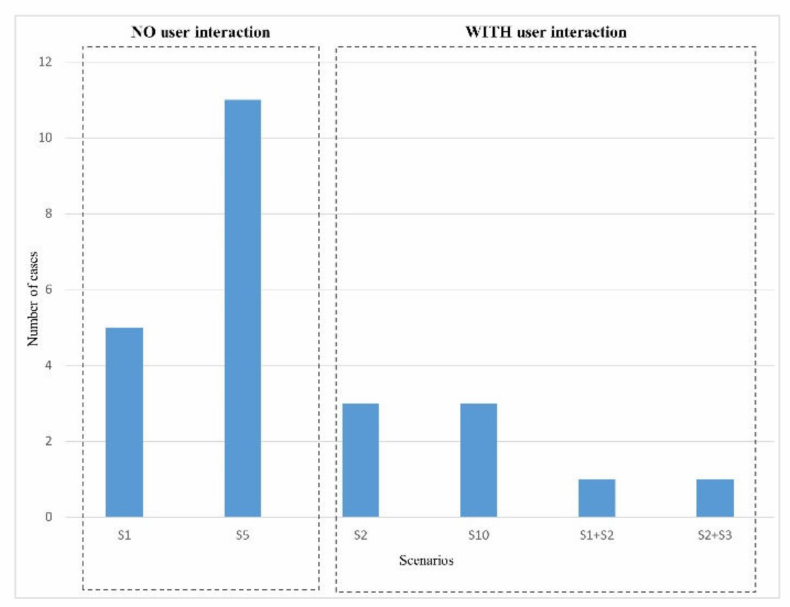
Figure 10. Number of cases per user–façade interaction scenario (Authors,